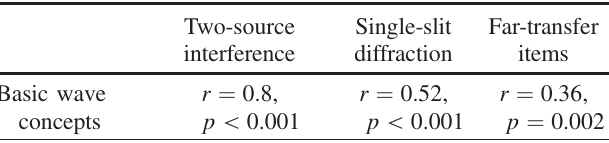
TABLE VII. Correlation between understanding basic wave concepts and understanding of prominent light interference and diffraction